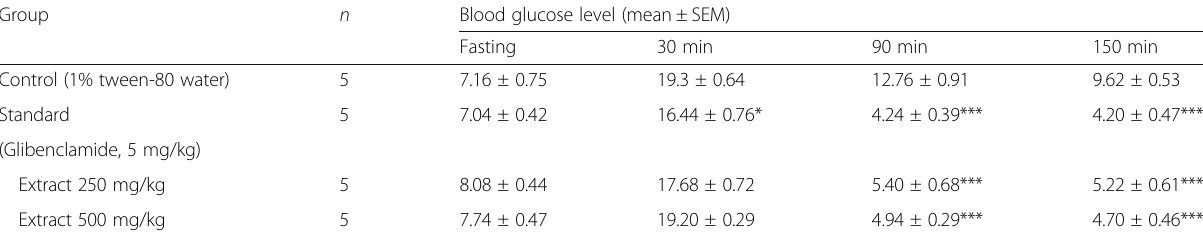
Table 2 Effect of the Lepisanthes rubiginosa L. ethanolic extract on oral glucose tolerance test (antihyperglycemic activity test) in normal control mice